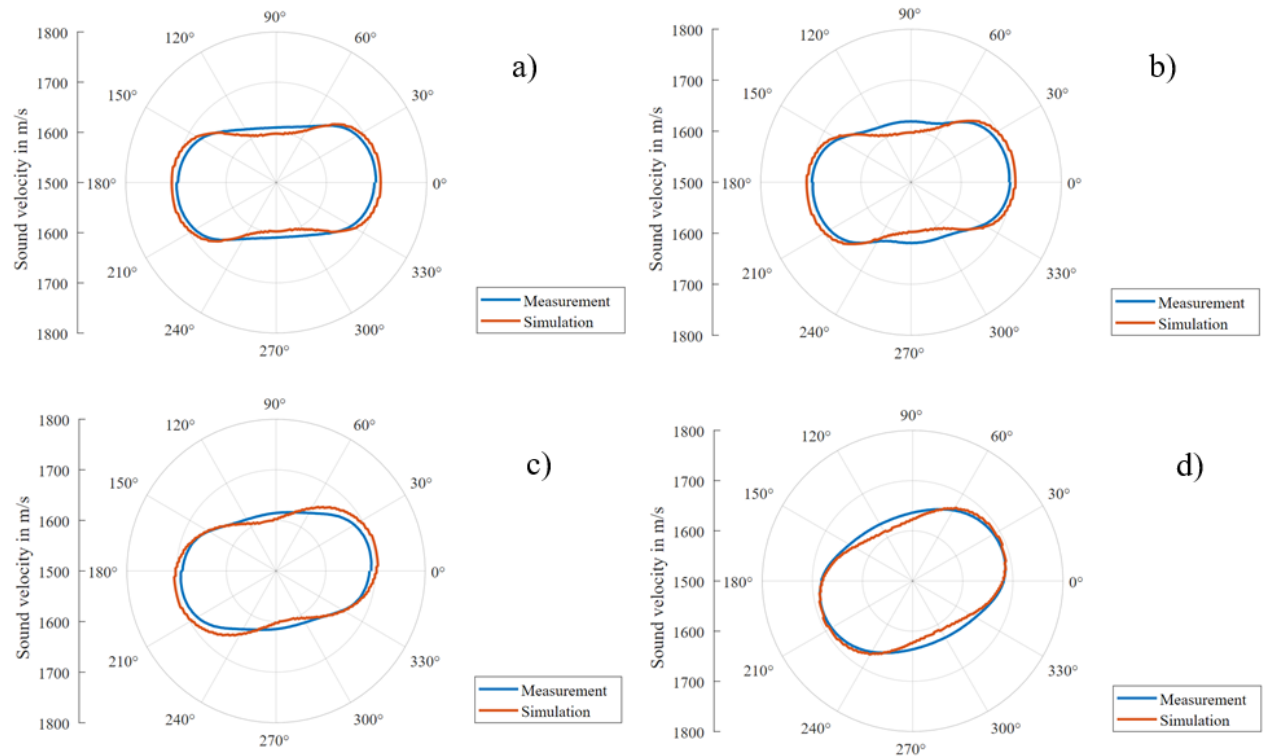
Figure 27. Comparison between measured and simulated polarization velocity curves for various fibre stacks in GFRP: ( a ) [0°/0°/5°/5°], ( b ) [0°/0°/10°/10°], ( c ) [0°/0°/20°/20°] plate, ( d ) [0°/0°/45°/45°] plates.